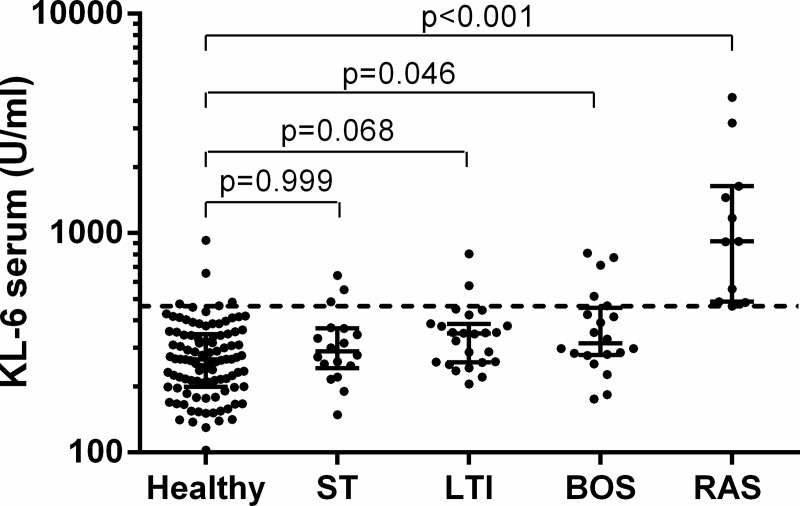
Comparison of serum KL-6 levels between healthy controls and lung transplant recipients.Solid lines indicate median and interquartile range. Dashed line indicates the cut-off value of 465U/ml. ST, Stable patients; LTI, Lung Transplant patients with an active Infection; BOS, Bronchiolitis Obliterans Syndrome; RAS; Restrictive Allograft Syndrome.